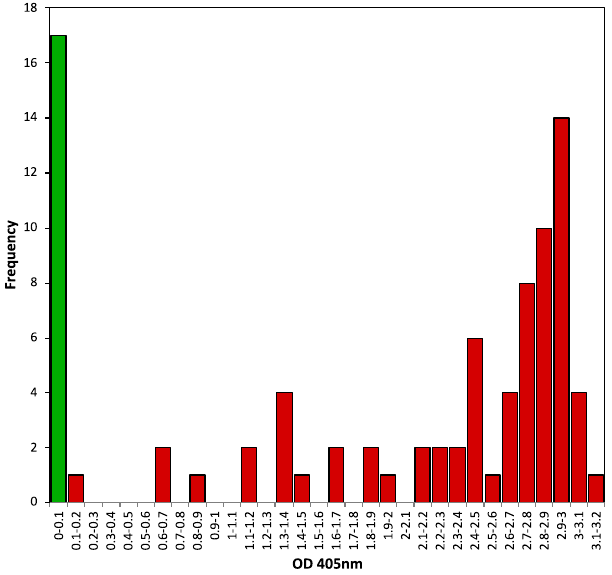
Fig. 4 Distribution of ELISA values in the 44628 progeny (87 individuals). The resistant plants (17 individuals) are in green and display a max_ELISA ranging from 0.004 to 0.011 (Supplementary Data 1), i.e., lower than the detection threshold (0.012). The susceptible plants (70 individuals) are in